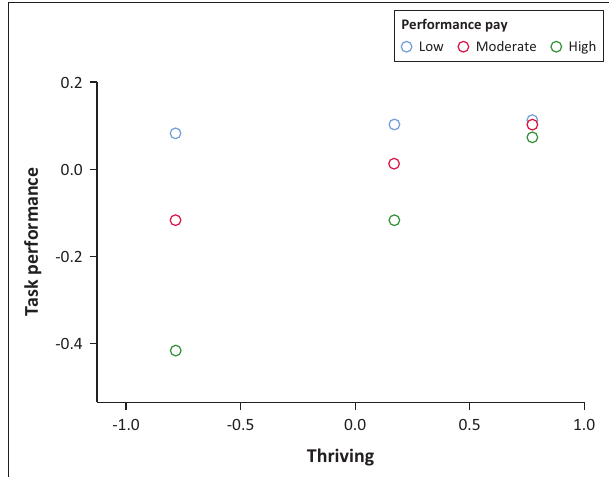
FIG URE 2: Interaction between thriving and performance-related pay.